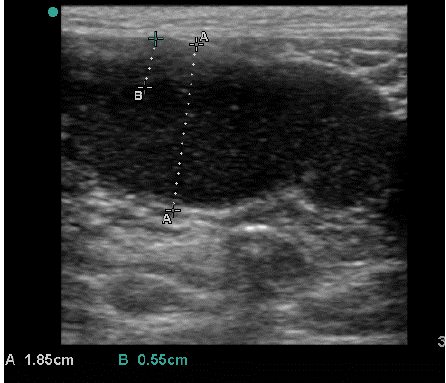
Figure 2. Recurrence of pyometra after medical treatment.